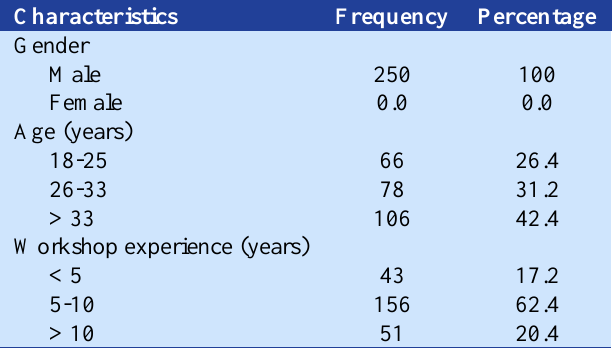
Table 2. Demographic characteristics of respondents